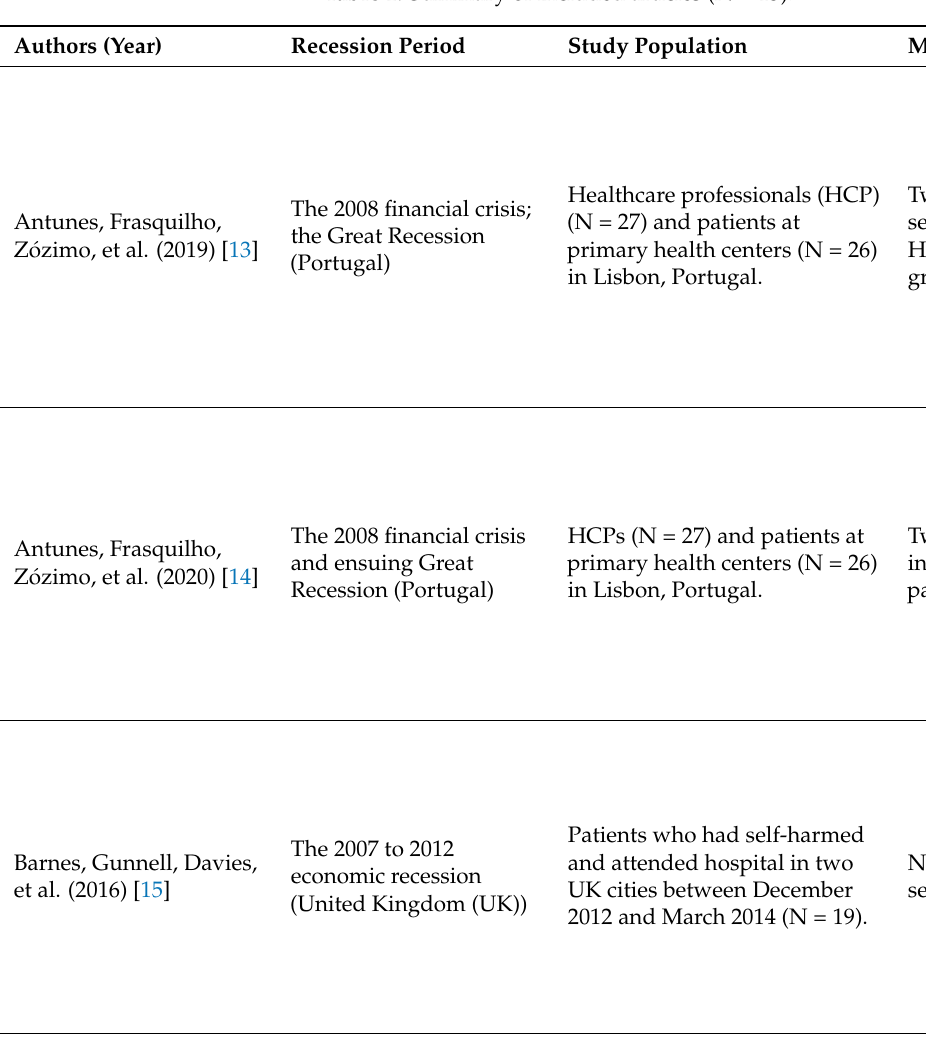
Table 1. Summary of included articles (N =